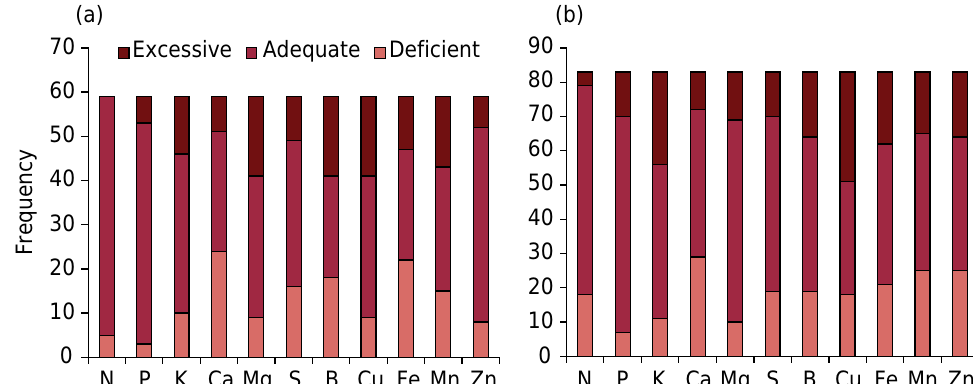
Figure 3. Response potential to fertilization in stands with young (≤6 years) (a) and adult (>6 years) (b) oil palm plants in the northeast of the state of Pará,